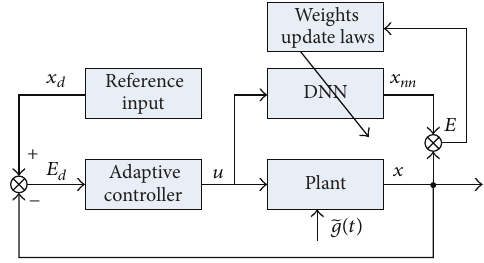
Figure 4: The architecture of indirect adaptive decoupling